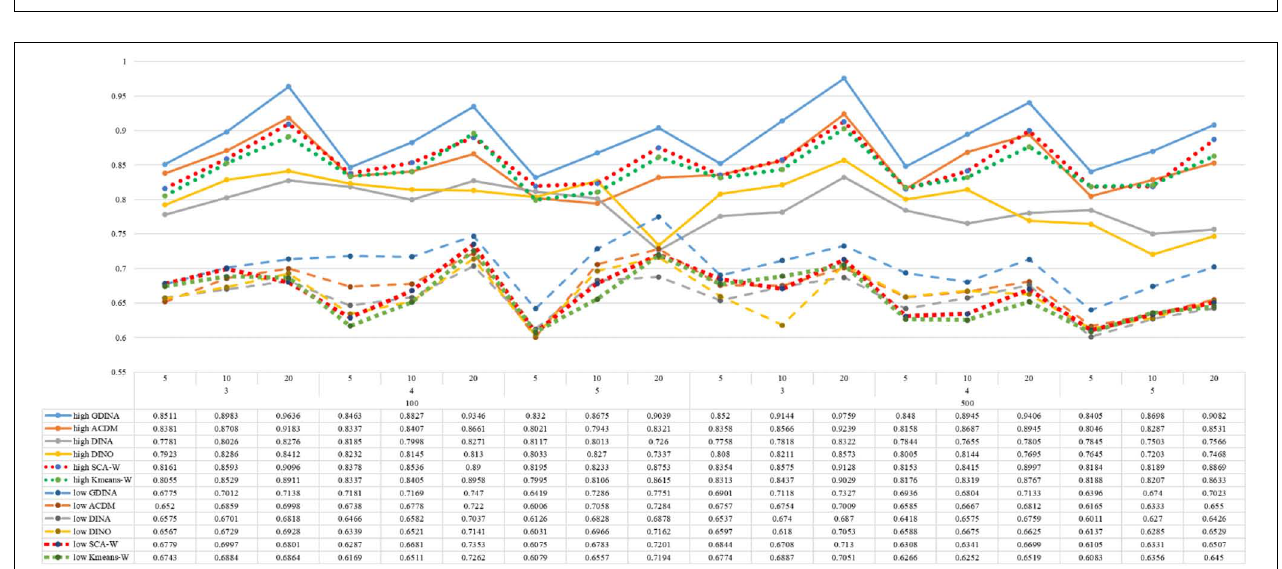
FIGURE 1 | Mean values of ARI by SCA, K-means, and fitted models; True model = G-DINA.